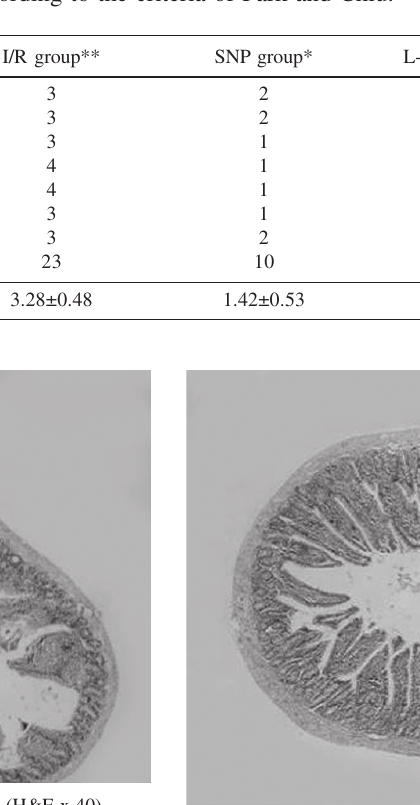
Table 1 - The histological injury scores according to the criteria of Park and Chiu.